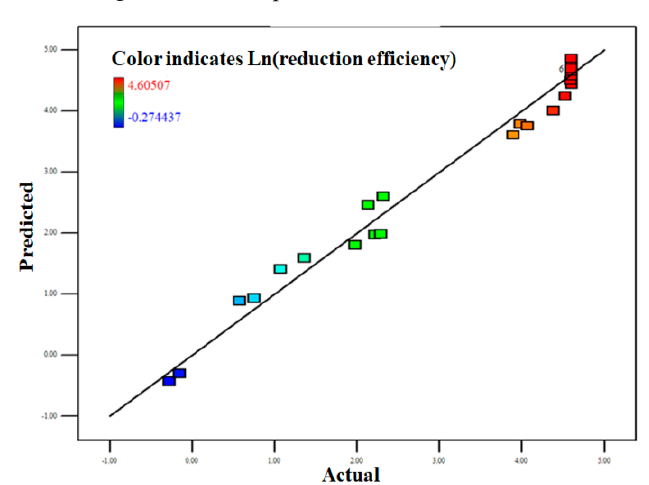
Figure 6. Plot of the predicted responses vs. the actual values.